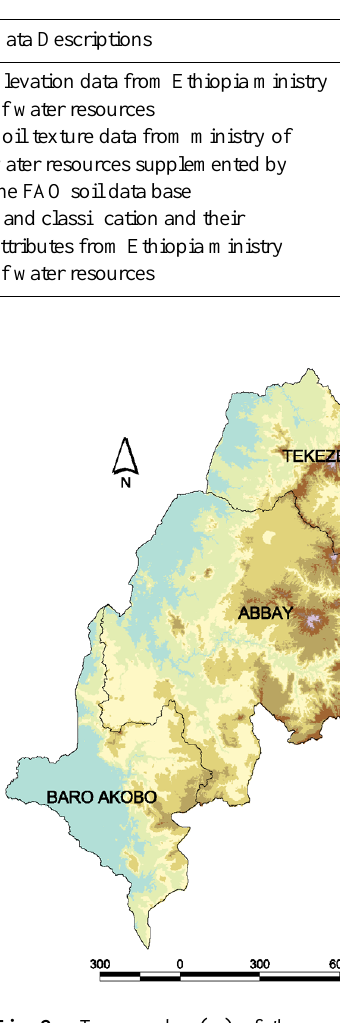
Fig. 2. Topography (m) of the eastern Nile basin based on a 1 × 1km digital elevation